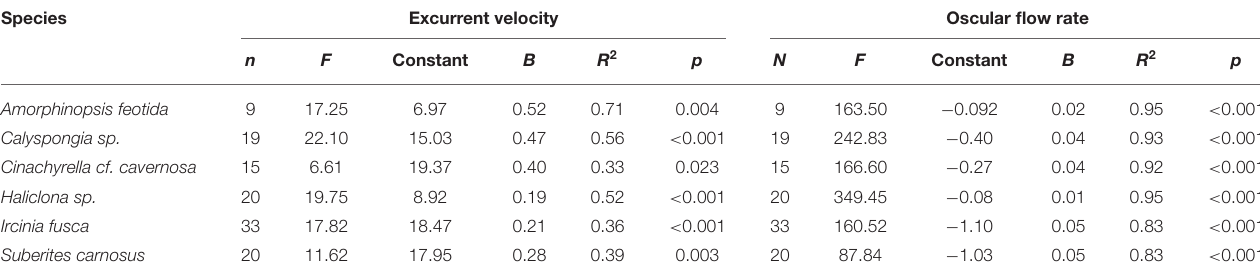
( Figures 4A,B and Table 2 ). Note that species that clustered tightly around the regression line, such as Haliclona sp. had small, non-contractile, and consistent oscular size within and between different individuals of different sizes, whereas species